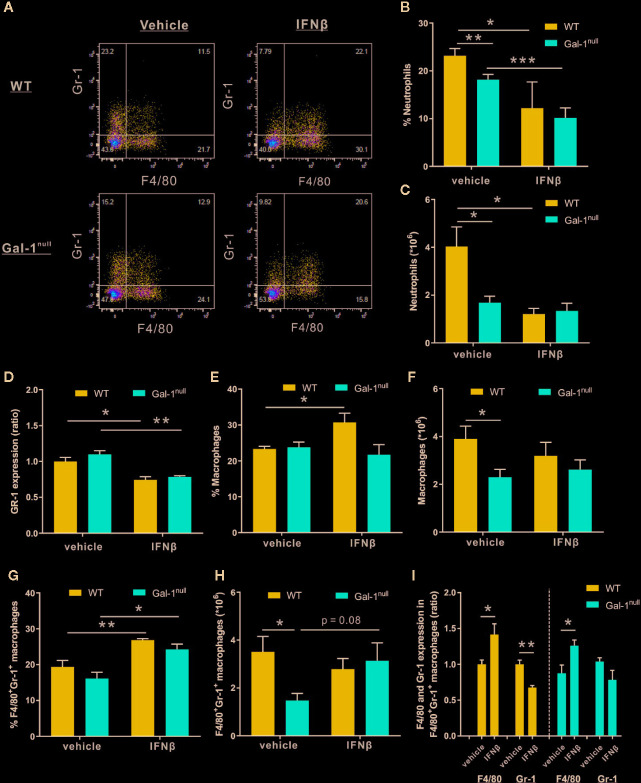
IFN-β reduces neutrophil and increases macrophage distribution in resolving exudates. WT and Gal-1null male mice undergoing peritonitis were administered with IFN-β or vehicle 24 h PPI, and their peritoneal exudates were collected 24 h later. Peritoneal leukocytes thereof were enumerated, immunostained for Gr-1 and F4/80, and analyzed by flow cytometry. (A) Representative dot plots. (B) The percentage of neutrophils. (C) The total number of neutrophils (D) The ratio of Gr-1 expression, based on MFI. (E) The percentage of macrophages (F) The total number of macrophages. (G) The percentage of F4/80+Gr-1+ macrophages. (H) The total number of F4/80+Gr-1+ macrophages. (I) The ratio of F4/80 and Gr-1 expression, based on MFI, in F4/80+Gr-1+ macrophages. Data are presented as mean ± SEM, n = 4. Statistical significance relative to vehicle-treated mice was analyzed by two-tailed Student's t-test; *p < 0.05, **p < 0.01.